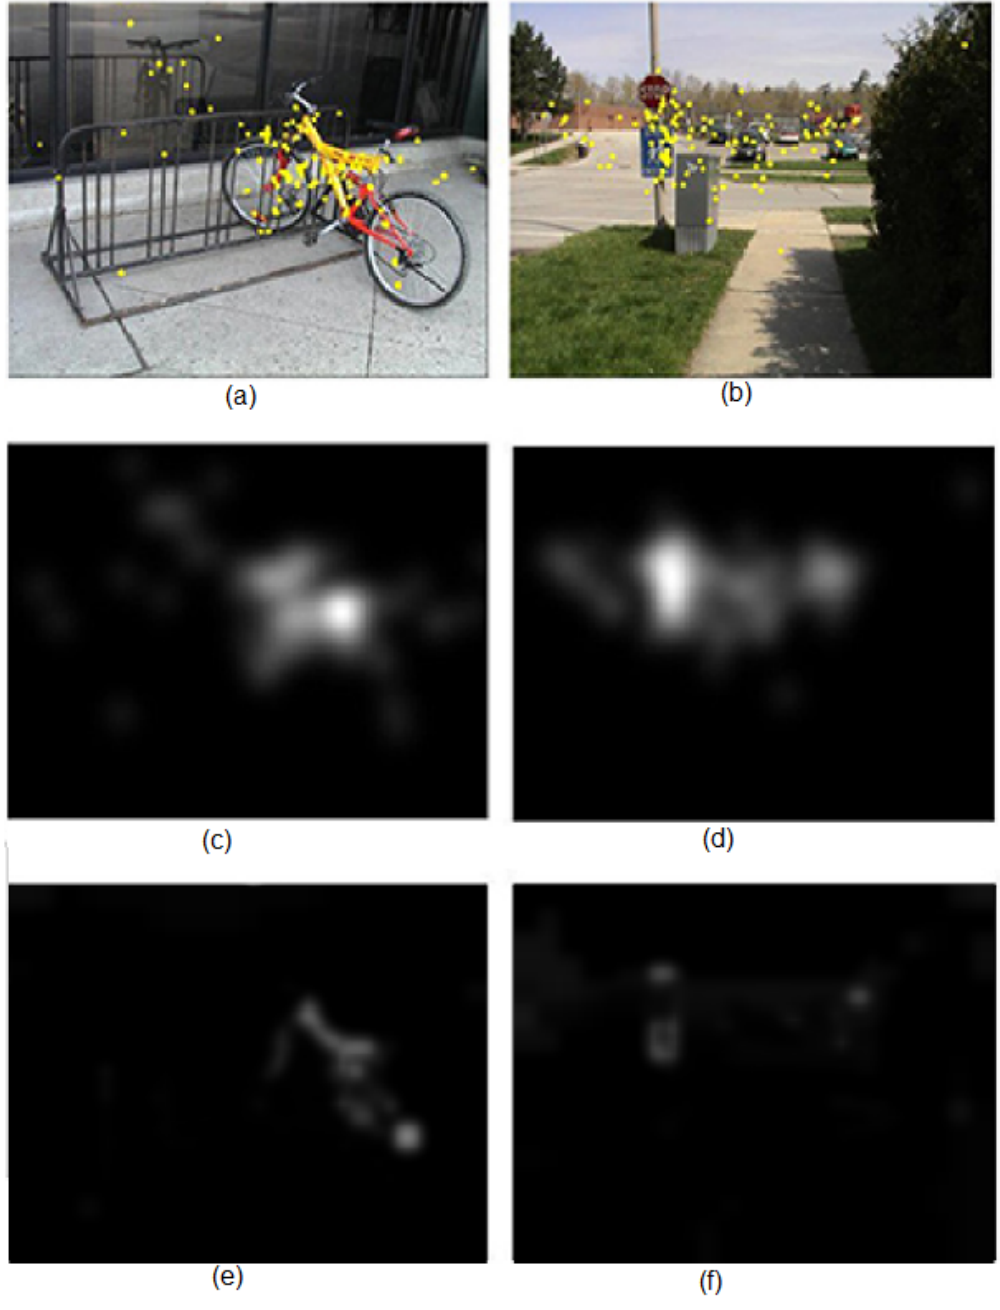
Figure 16. ( a , b ) Images from the Toronto database, annotated with the eye fixation points (see the text for details); ( c , d ) Density maps obtained from the fixation points from 20 people; and ( e , f ) Density maps obtained using the proposed